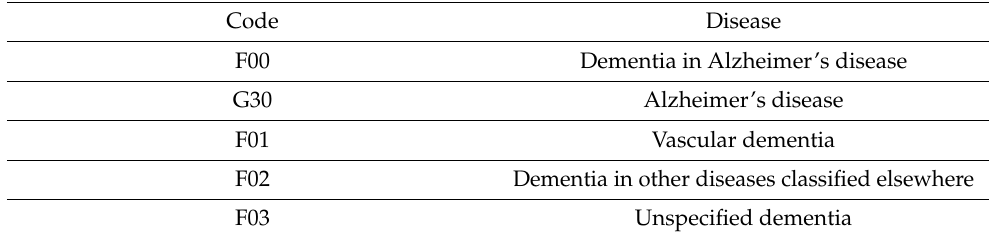
Table A1. KCD code of